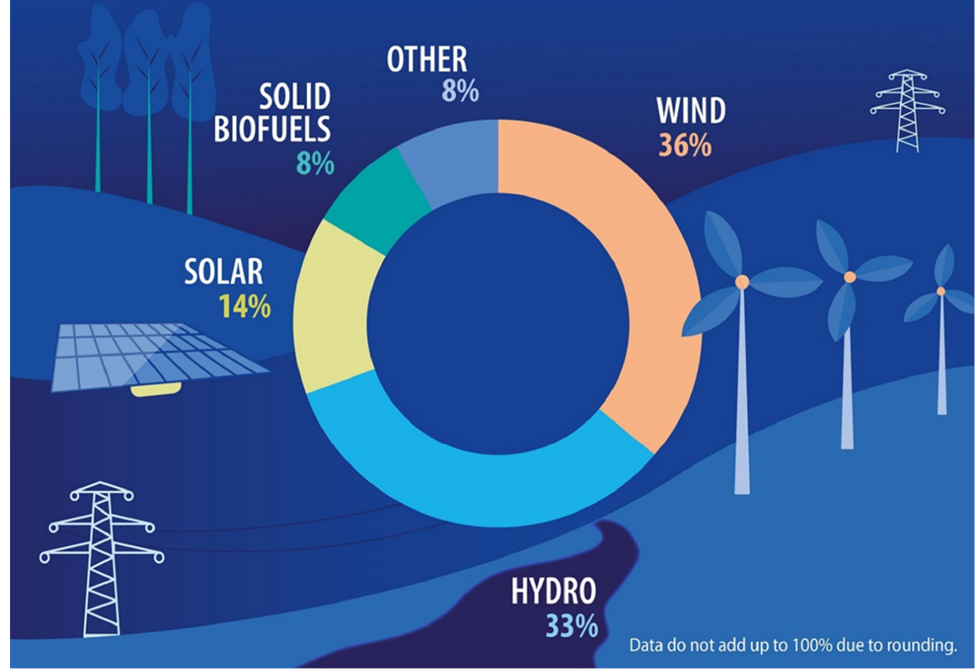
Figure 3. Renewable sources generating electricity in EU in 2020 [46].